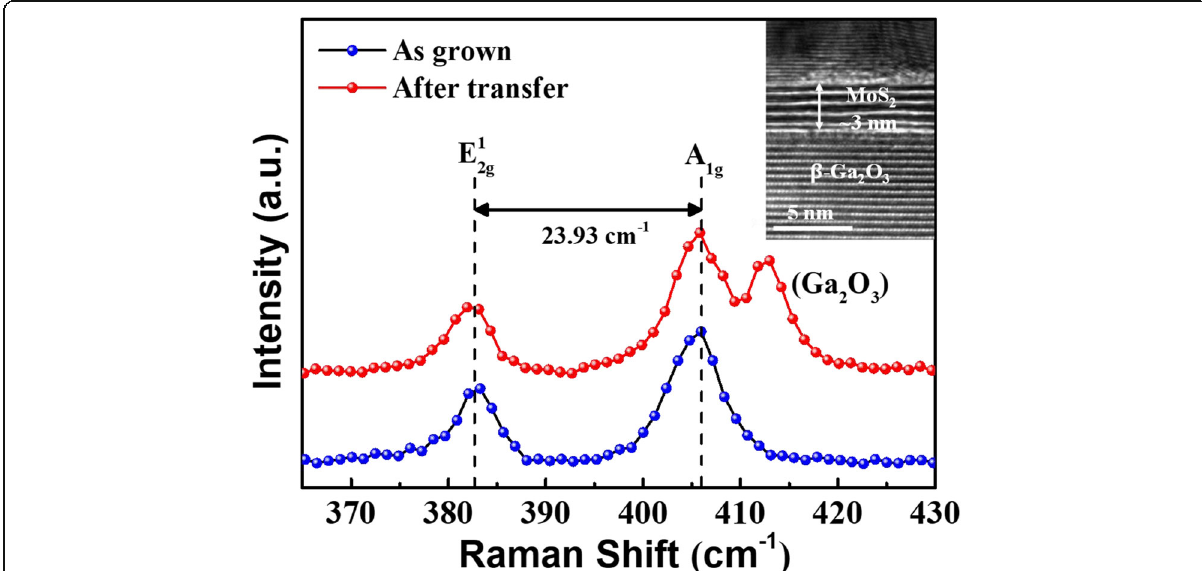
Fig. 2 Raman spectra of as-grown MoS 2 on SiO 2 /Si substrate and transferred MoS 2 on β -Ga 2 O 3 substrate, respectively. The inset shows cross- section transmission electron microscopy (TEM) image of fabricated MoS 2 / β -Ga 2 O 3